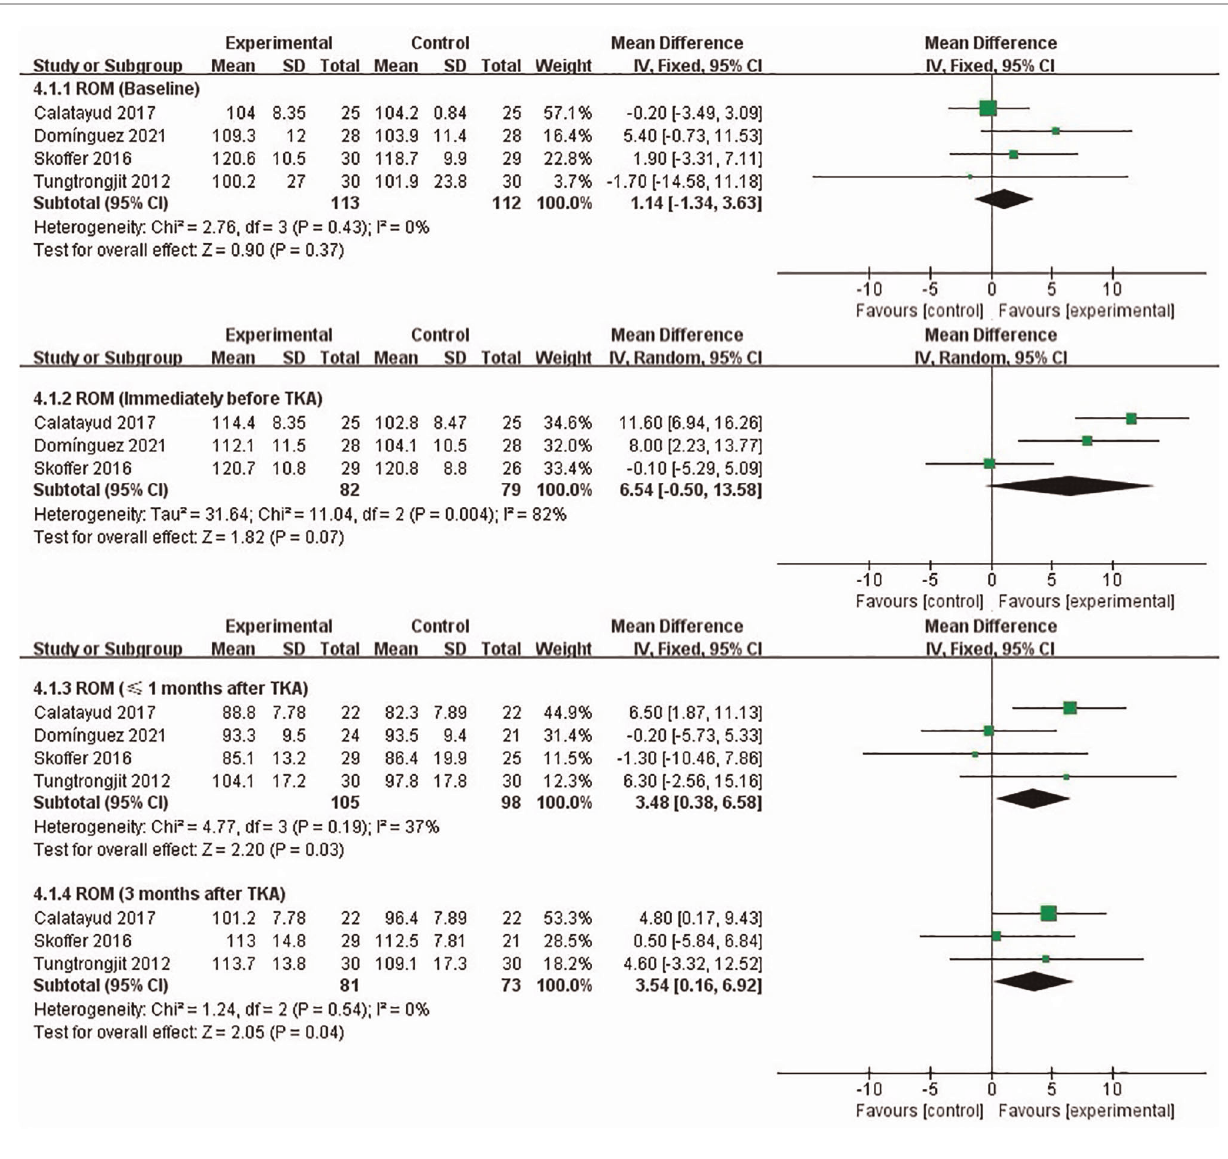
FIGURE 6 | Meta-analysis on